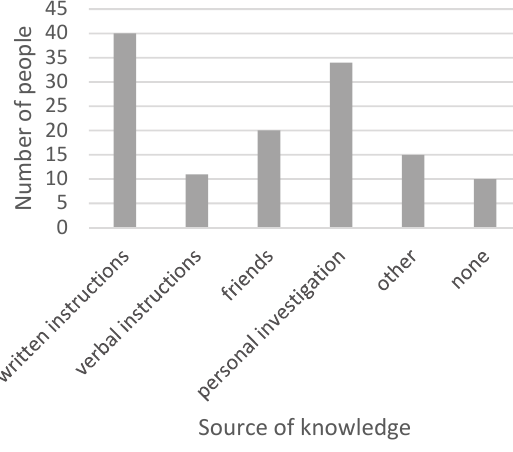
Figure A9. Perceived source of knowledge, first survey (106 individuals).